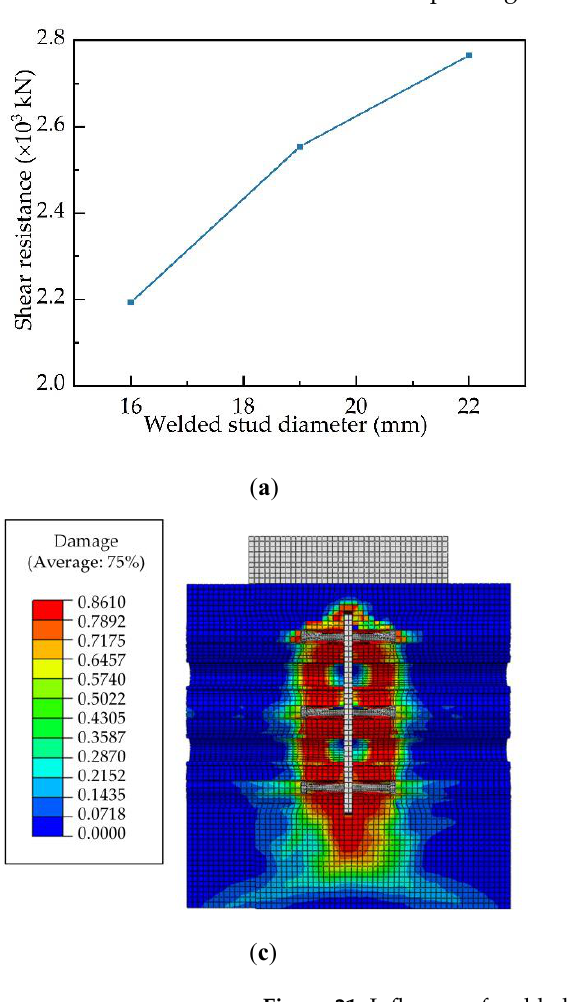
Figure 21. Influence of welded stud diameter: ( a ) shear resistance; ( b ) compressive damages cloud map of 16 mm welded stud; ( c ) compressive damages cloud map of 19 mm welded stud; ( d ) com- pressive damages cloud map of 22 mm welded stud.